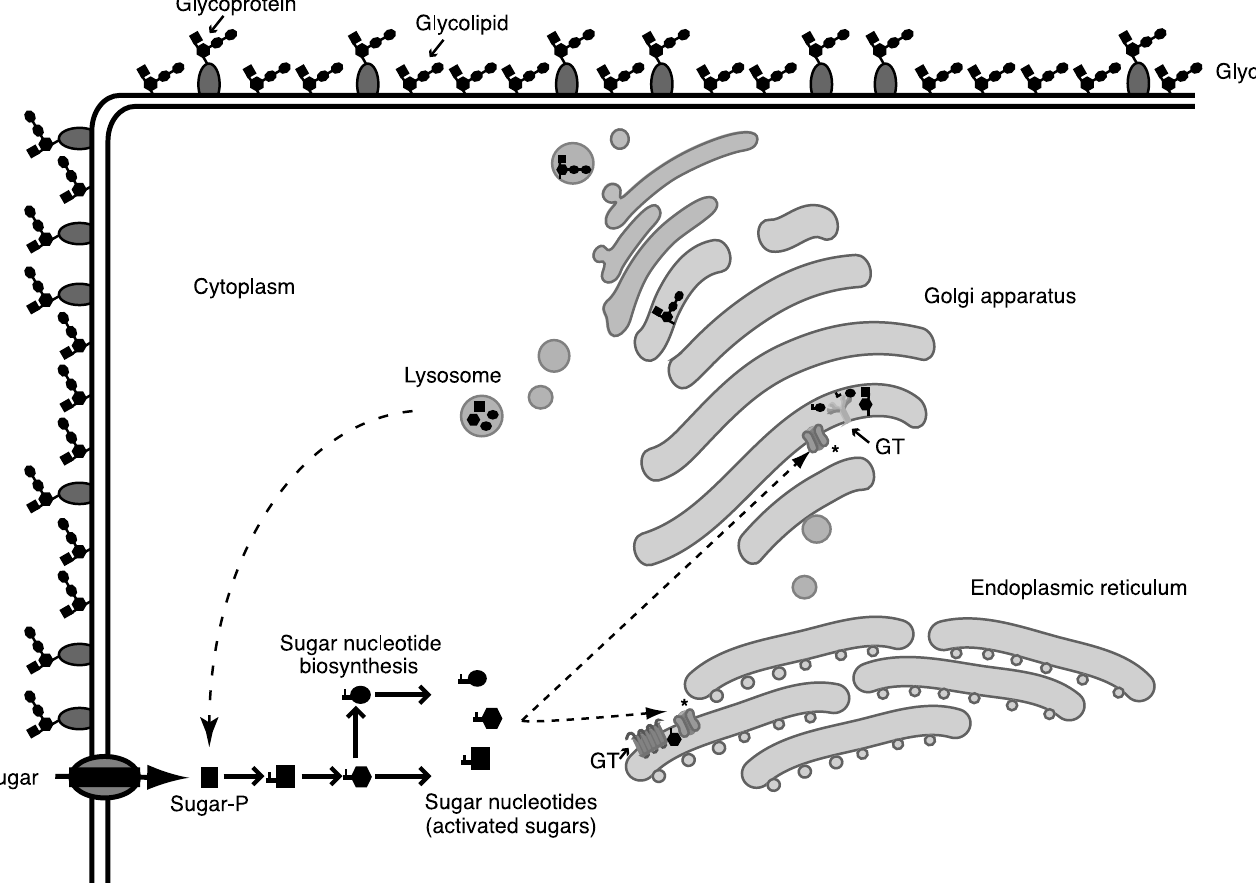
Fig 2. Glycosylation processes involve different cellular compartments. Glycan biosynthesis and cellular compartments involved in the glycosylation process. Sugars are carried across the plasma membrane into cells or are salvaged from degraded glycoconjugates at lysosomes. Through biosynthetic and interconversion reactions, monosaccharides are activated into different nucleotide sugars. Sugar activation generally takes place in the cytoplasm, although several enzymes involved in sugar nucleotide biosynthesis in T . b . brucei are localized in the glycosome. After being activated, sugar nucleotides are transported into the endoplasmic reticulum/Golgi apparatus and used by different glycosyltransferases (GT). Glycosyltransferases and other glycan- processing enzymes define the assembly and final structure of glycans that are secreted or located in the cell surface, forming a protective glycocalyx. Sugar nucleotide transporters are marked with an asterisk ( *